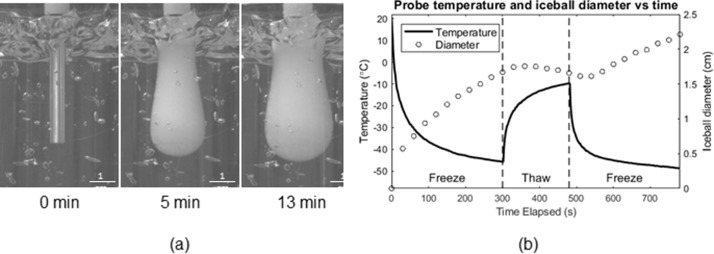
(a) Iceball growth over time as visualized in the tissue phantom, (b) plot of probe temperature at the cryoprobe tip and iceball diameter over time demonstrating temperatures below -40°C and iceball diameters larger than 2 cm.